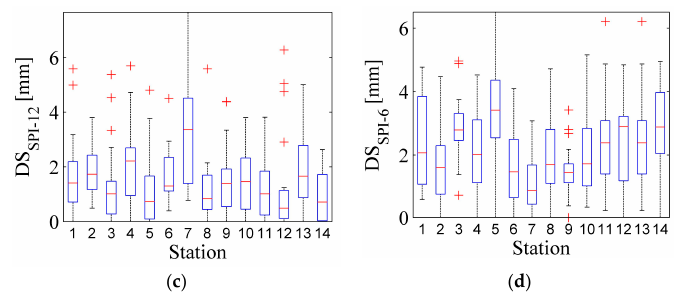
Figure 4. Drought Severity (DS) across the Free State and North West Provinces. ( a ) Drought severity computed using SPEI 12 values; ( b ) drought severity computed using SPEI 6 values; ( c ) drought severity computed using SPI 12 values and ( d ) drought severity computed using SPI 6 values.